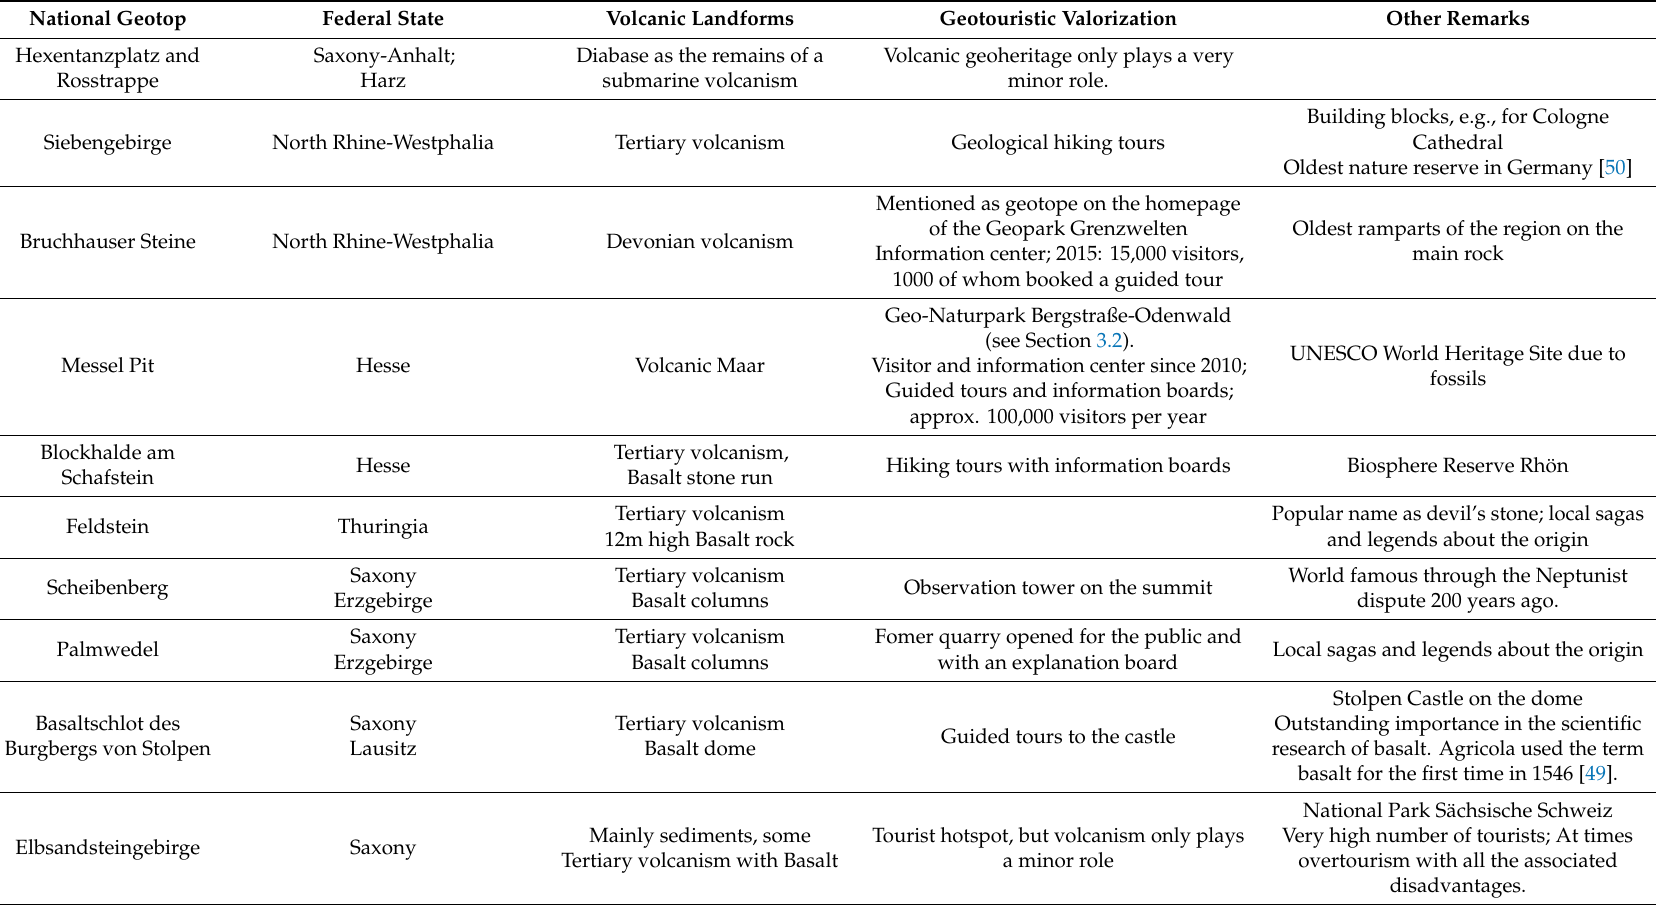
Table 2. National Geotopes of volcanic origin (Author’s